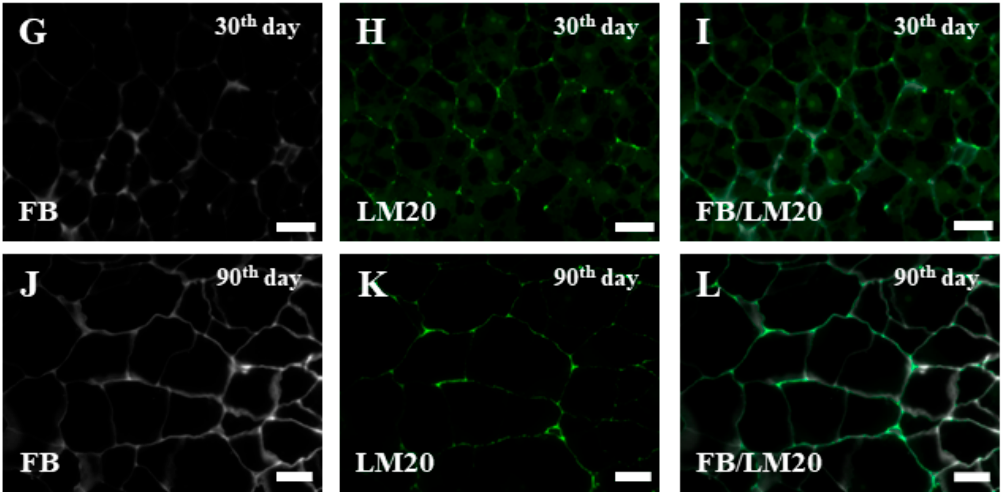
Figure S5. Immunolocalisation of LM6 ( A - F ) and LM20 ( G – L ) in B. distachyon callus. ( A – C , G – I ) 30th day of cultivation; ( D – F , J – L ) 90th day of cultivation. The red arrows indicate the presence of the epitope on the callus surface. Scale bars, 10 μ m.